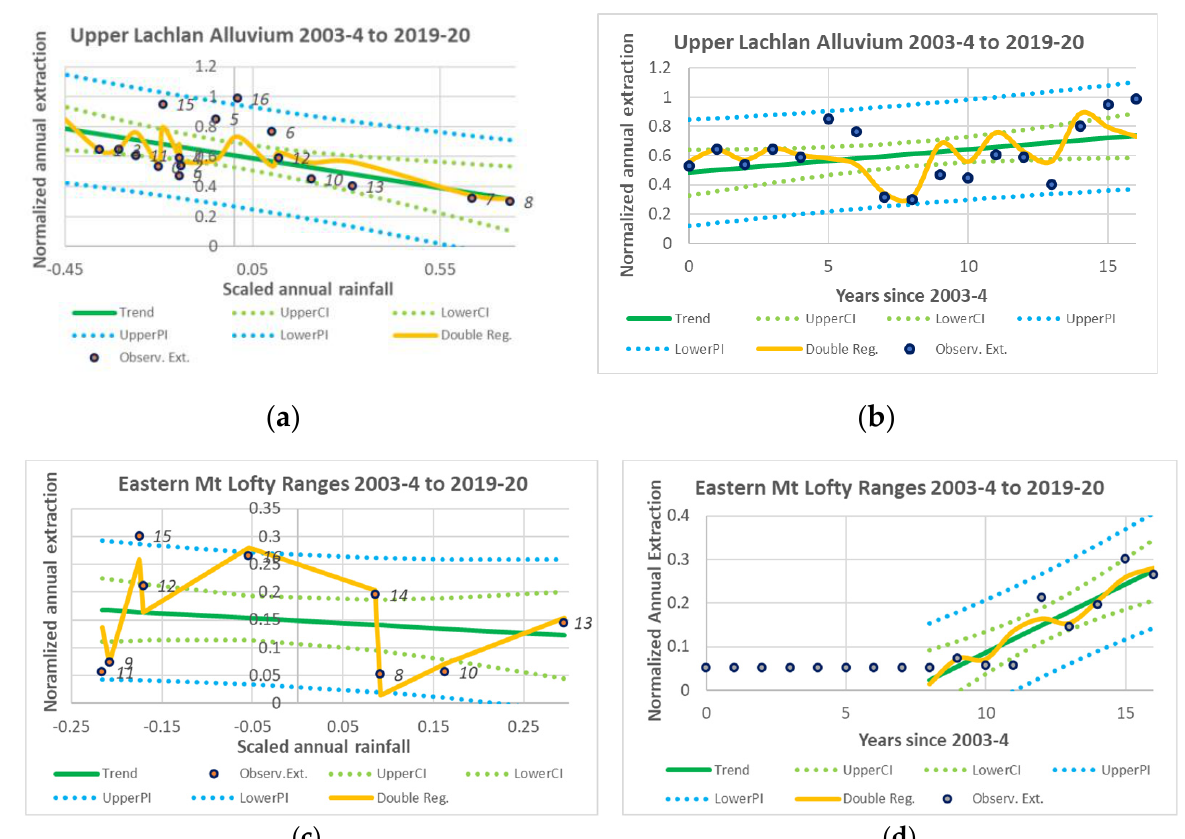
Figure 6. Plots of the observed normalized annual extraction and multi-regression trend and full regression lines for the Upper Lachlan Alluvium, together with confidence and prediction intervals ( a , b ) and eastern Mt Lofty Ranges’ ( c , d ) units for the period of 2003–2004 to 2019–2020. Plots ( a ) and ( c ) are against scaled annual rainfall, while ( b , c ) are against time (years since 2003–2004). Labels for ( a , c ) represent the years since 2003–2004.